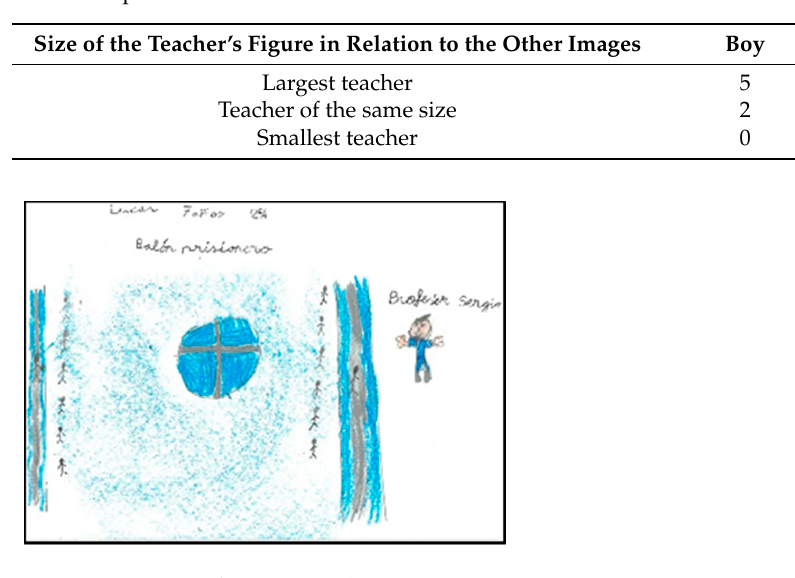
Figure 2. Larger teacher. Sergio. 2°A.